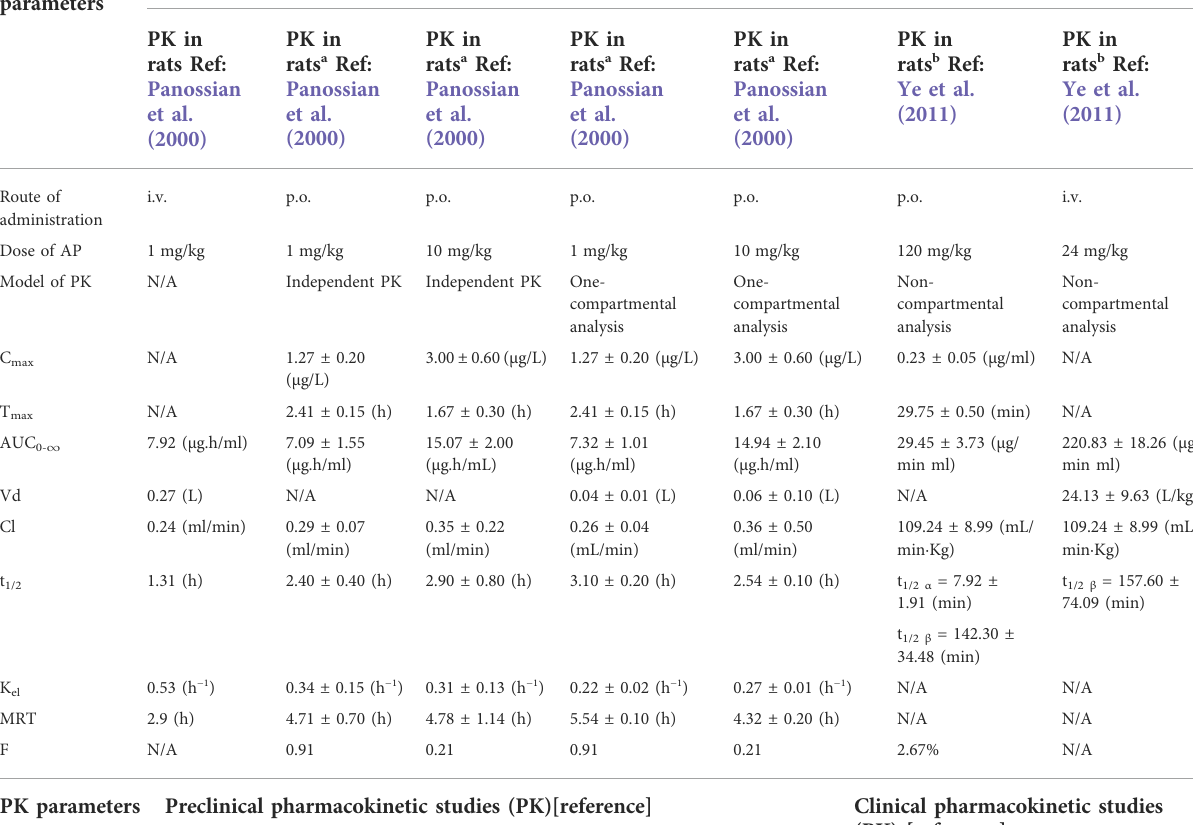
TABLE 3 Pharmacokinetic parameters of andrographolide (AP) in preclinical and clinical studies. PK